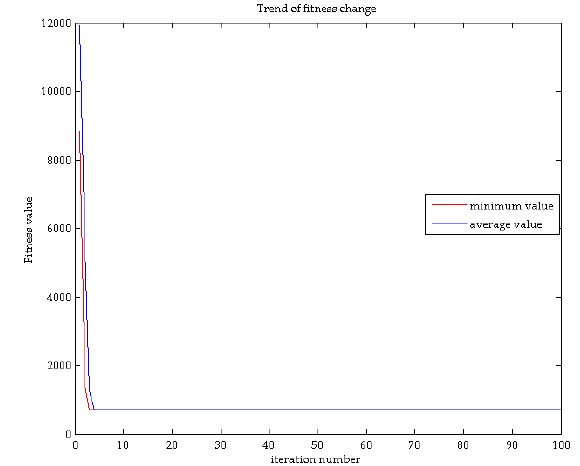
Figure 6. The trend of adaptation value at the lowest charging cost.